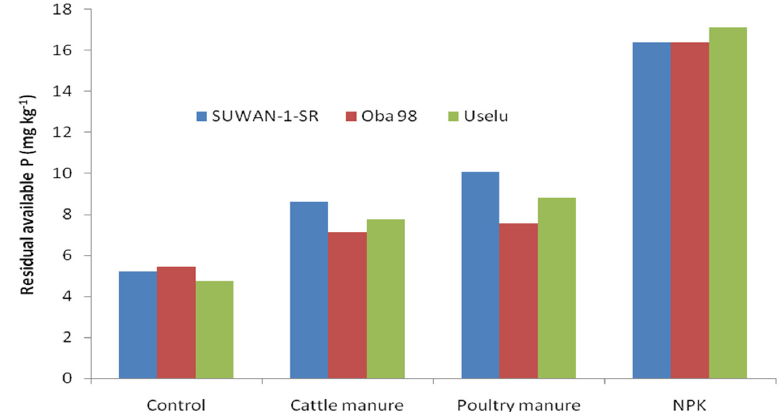
Figure 2. Interaction of maize variety and soil amendment on residual soil available